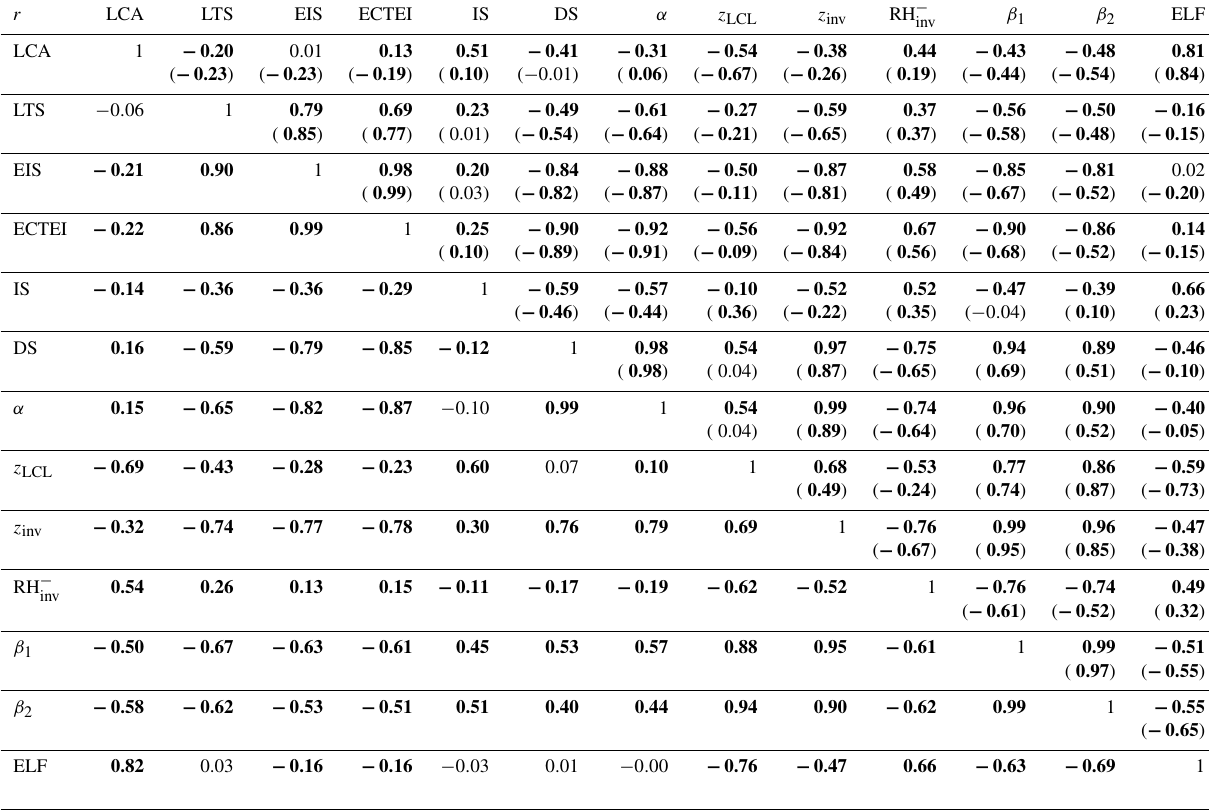
Table 4. The same as Table 1, but all data (i.e., 0 < α < 1 and α = 0 and α = 1) are used for this